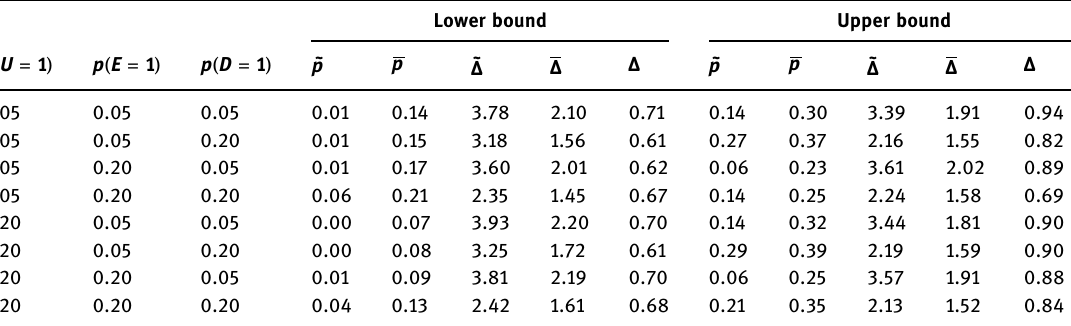
Table 5: Simulation results with σ 3 = , and parameter values that are 15% more conservative than the true values. p ˜ and p are the proportions of times that AS ’ bounds and our bounds are tighter than DV ’ s bounds, respectively. Δ˜ , Δ and Δ are the mean absolute distance between the log of the bound and the log of the true risk ratio for AS ’ bounds, our bounds and DV ’ s bounds, respectively Lower bound Upper bound p U 1 ( =